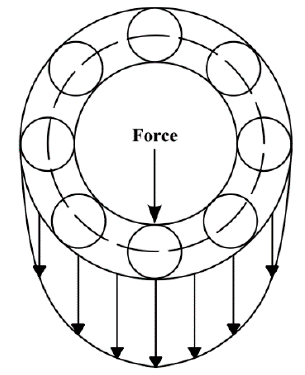
Figure 3. Load distribution of roller bearing.